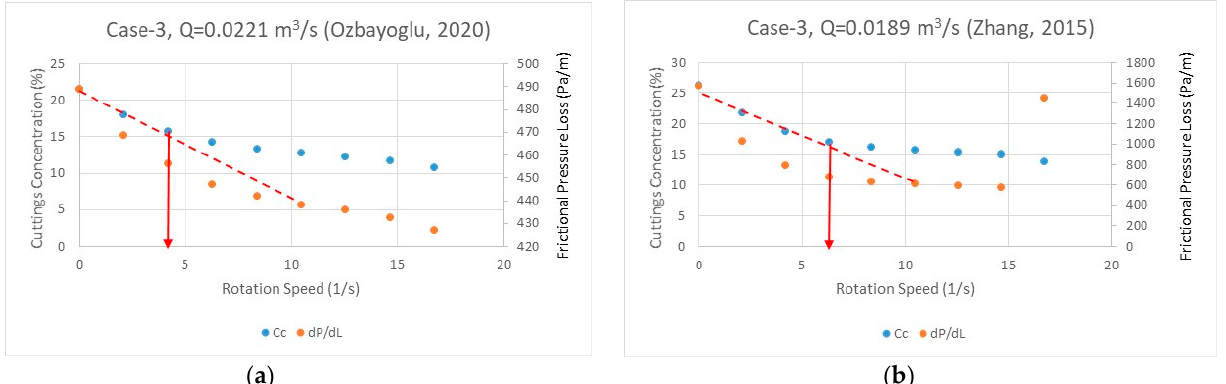
Figure 9. Determination of the optimal pipe rotation speed after the optimal flow rate is determined for Case 3: ( a ) Ozbayoglu’s model and ( b ) Zhang’s model.